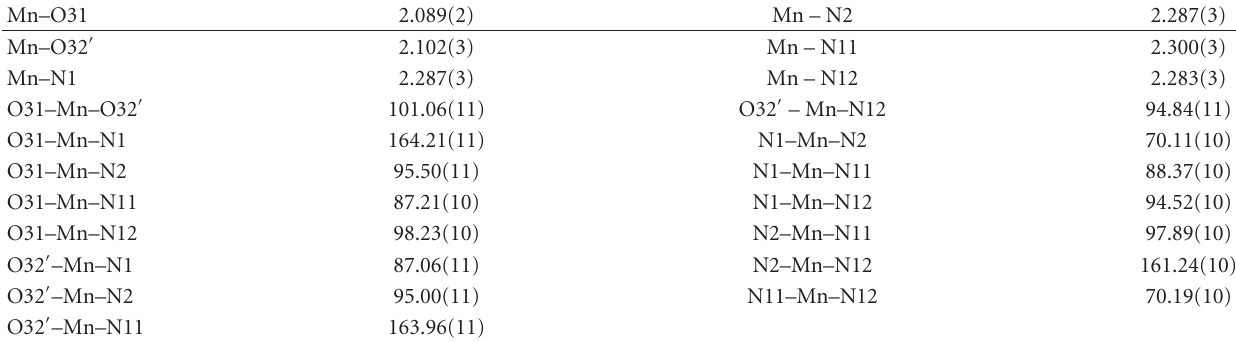
Table 2: Selected dond lengths (˚A) and angles ( ◦ ) for 1 · (py)C(Me)NOH .